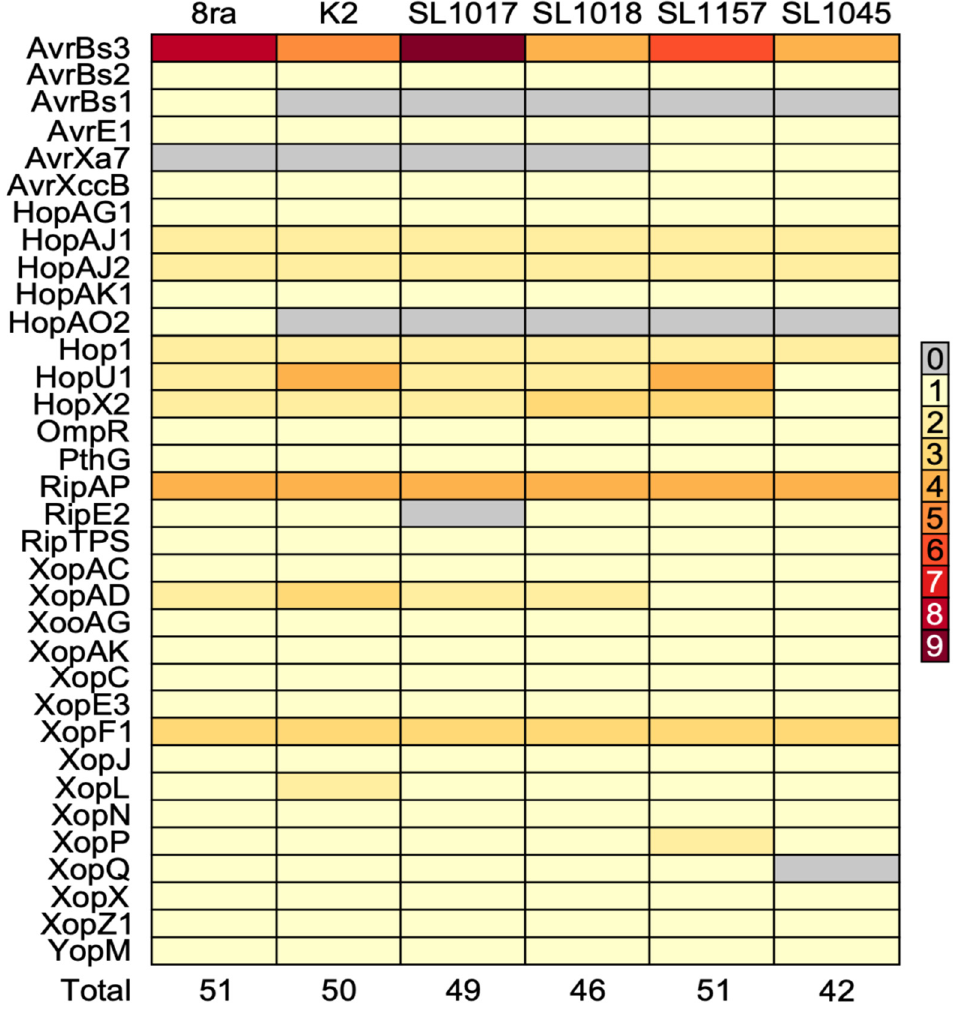
Figure 6. Number of type III secretion system effectors in the five Korean X. citri pv. glycines strains and the US strain 8ra. The colors represent the number of genes for each effector.